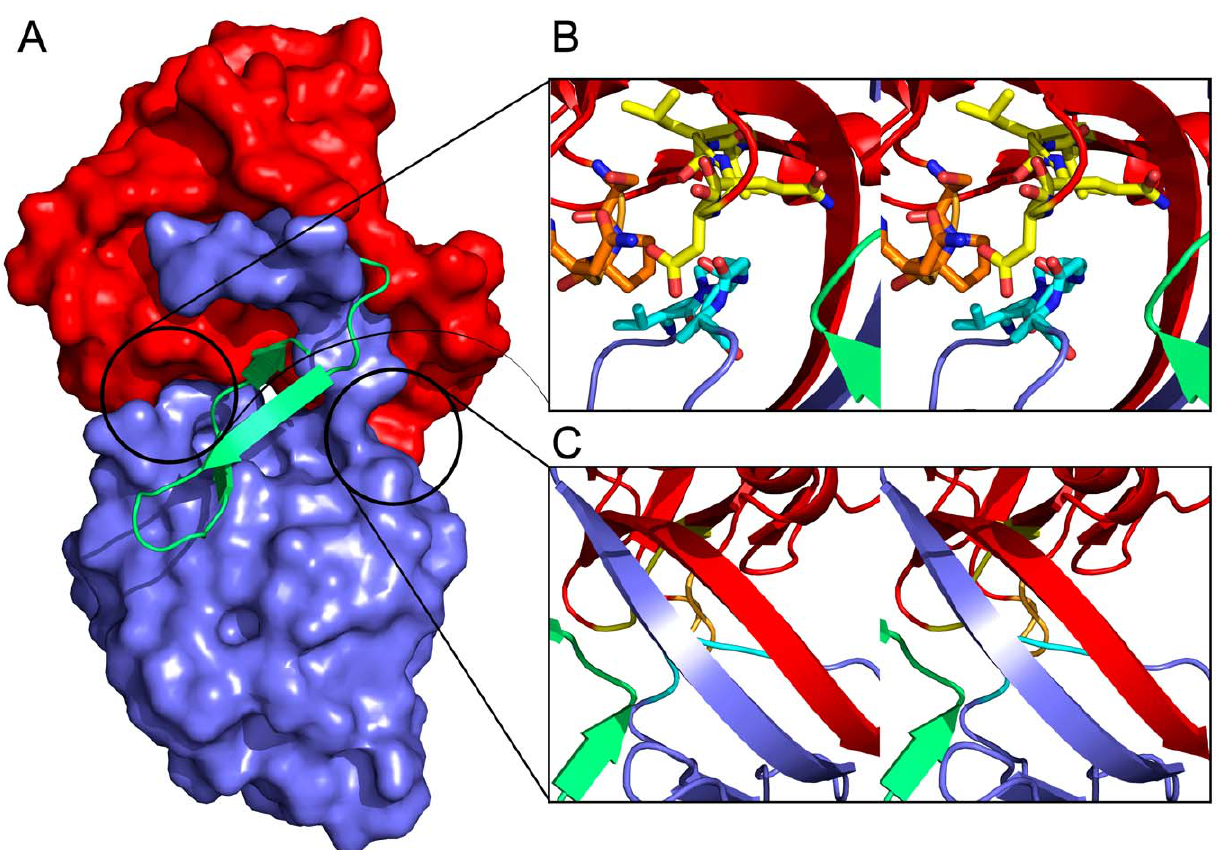
Figure 2. Domain interactions within LlpA BW . (A) The C-terminal hairpin extension (green cartoon) covers the interface between the N-domain (red surface representation) and the C-domain (blue surface representation). (B) Stereo view of the interactions between loop segments Val140- Asp145 (cyan) of the C-domain and Val115-Asp118 (yellow) and Ser31-Gln34 (orange) of the N-domain. Other structural elements are colored according to panel A. (C) Stereo view of the two-stranded b -sheet formed by strands b 11a,b and b 22a,b that links the N- and the C-domains and gives rise to domain swapping. Colors according to panel A and B.